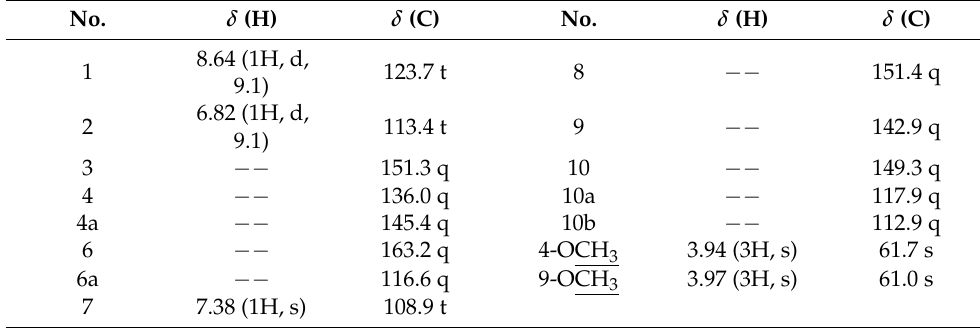
Table 2. 1 H and 13 C NMR data of compound 8 , δ in ppm and J in Hz.